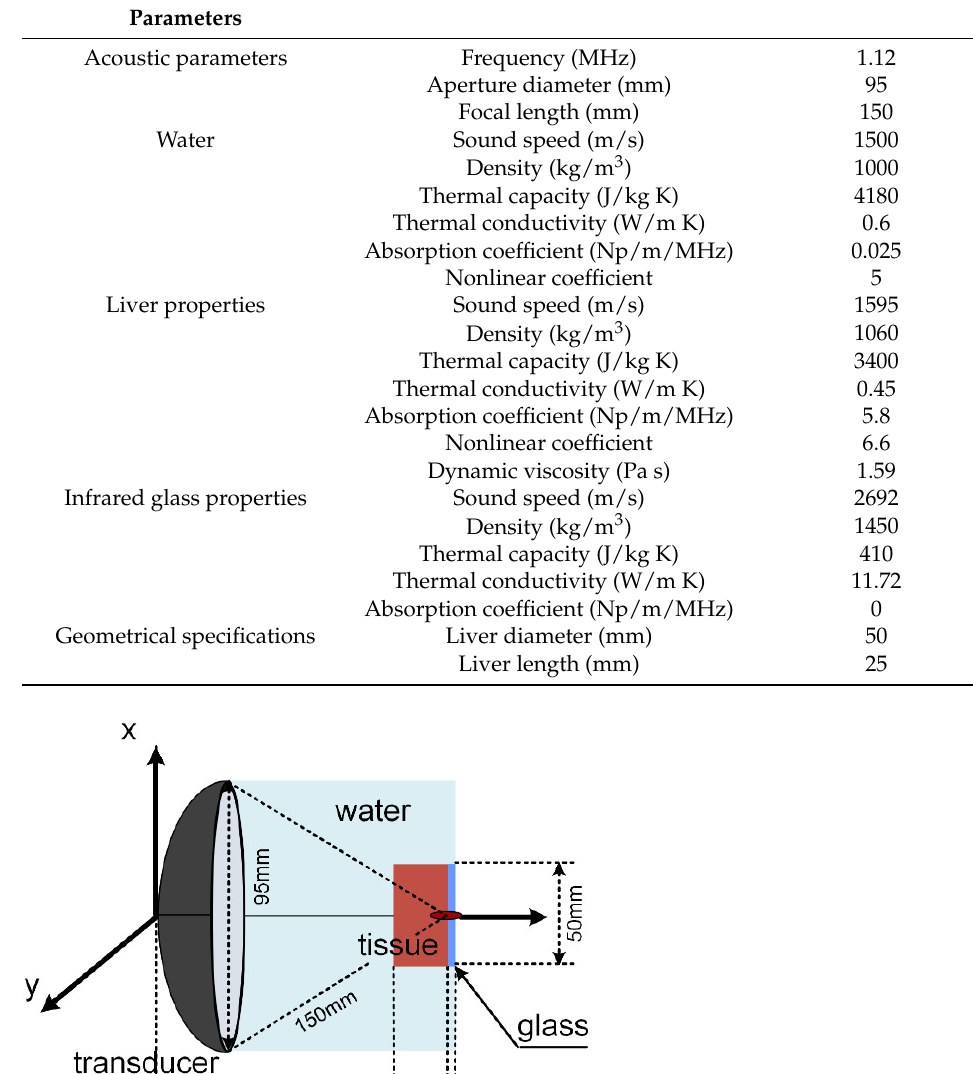
Figure 1. Schematic diagram of the simulation model without infrared glass. Table 1. Parameters for simulation research.